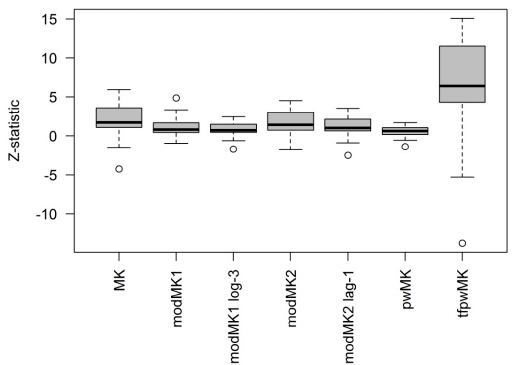
Figure 11. Box plot showing the results of the Z statistic for each trend test applied on SPI-12 time